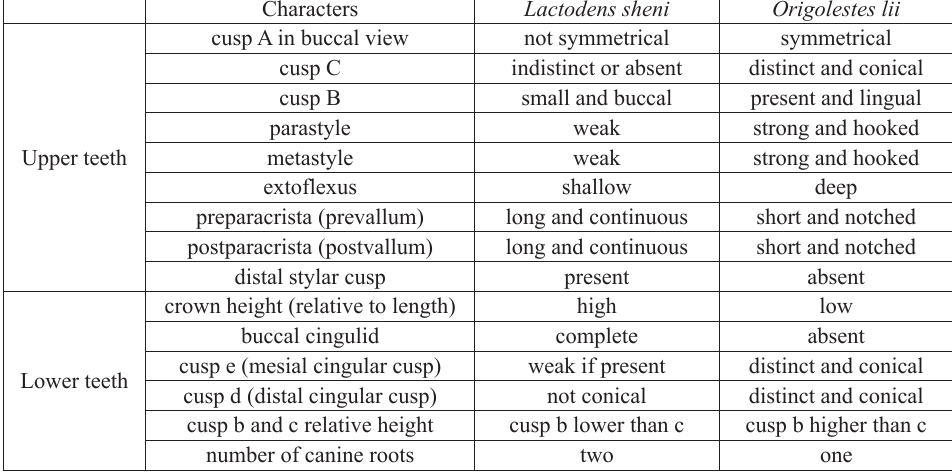
Table 2. Comparison of dental characters between Lactodens sheni Han and Meng, 2016, and Origolestes lii Mao, Hu, Li, Wang, Chase, Smith, and Meng,